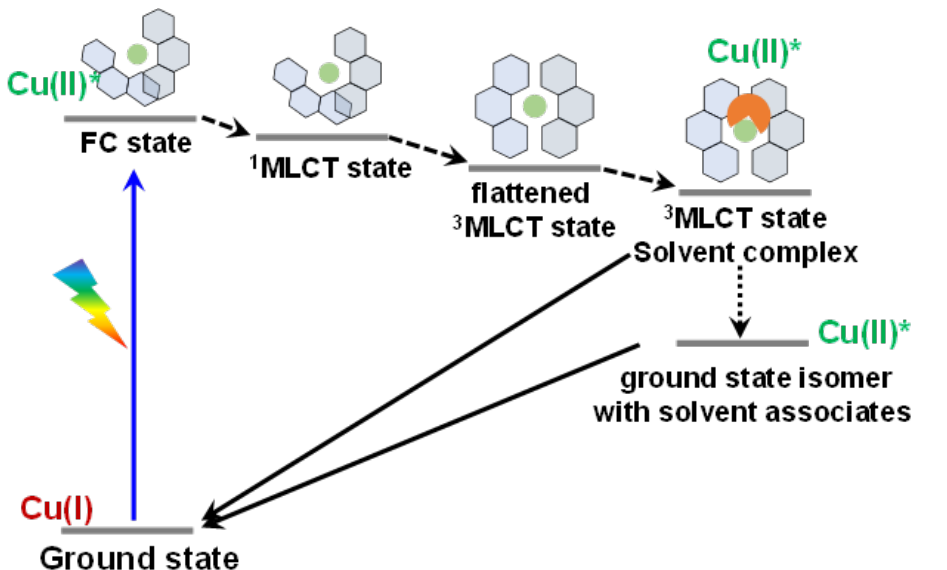
Figure 9. Photochemical process of copper-based photosensitizers (Cu(I): ground state, Cu(II)*: excited state).